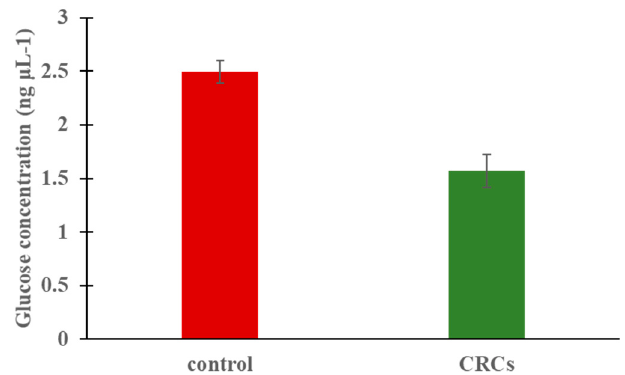
Figure 1. Glucose levels at zebrafish larvae following 48h treatment with CRCs at the concentration of 0.2 mg/mL. Data are mean +/ − standard error of the mean (SEM), n = 3, p < 0.05.